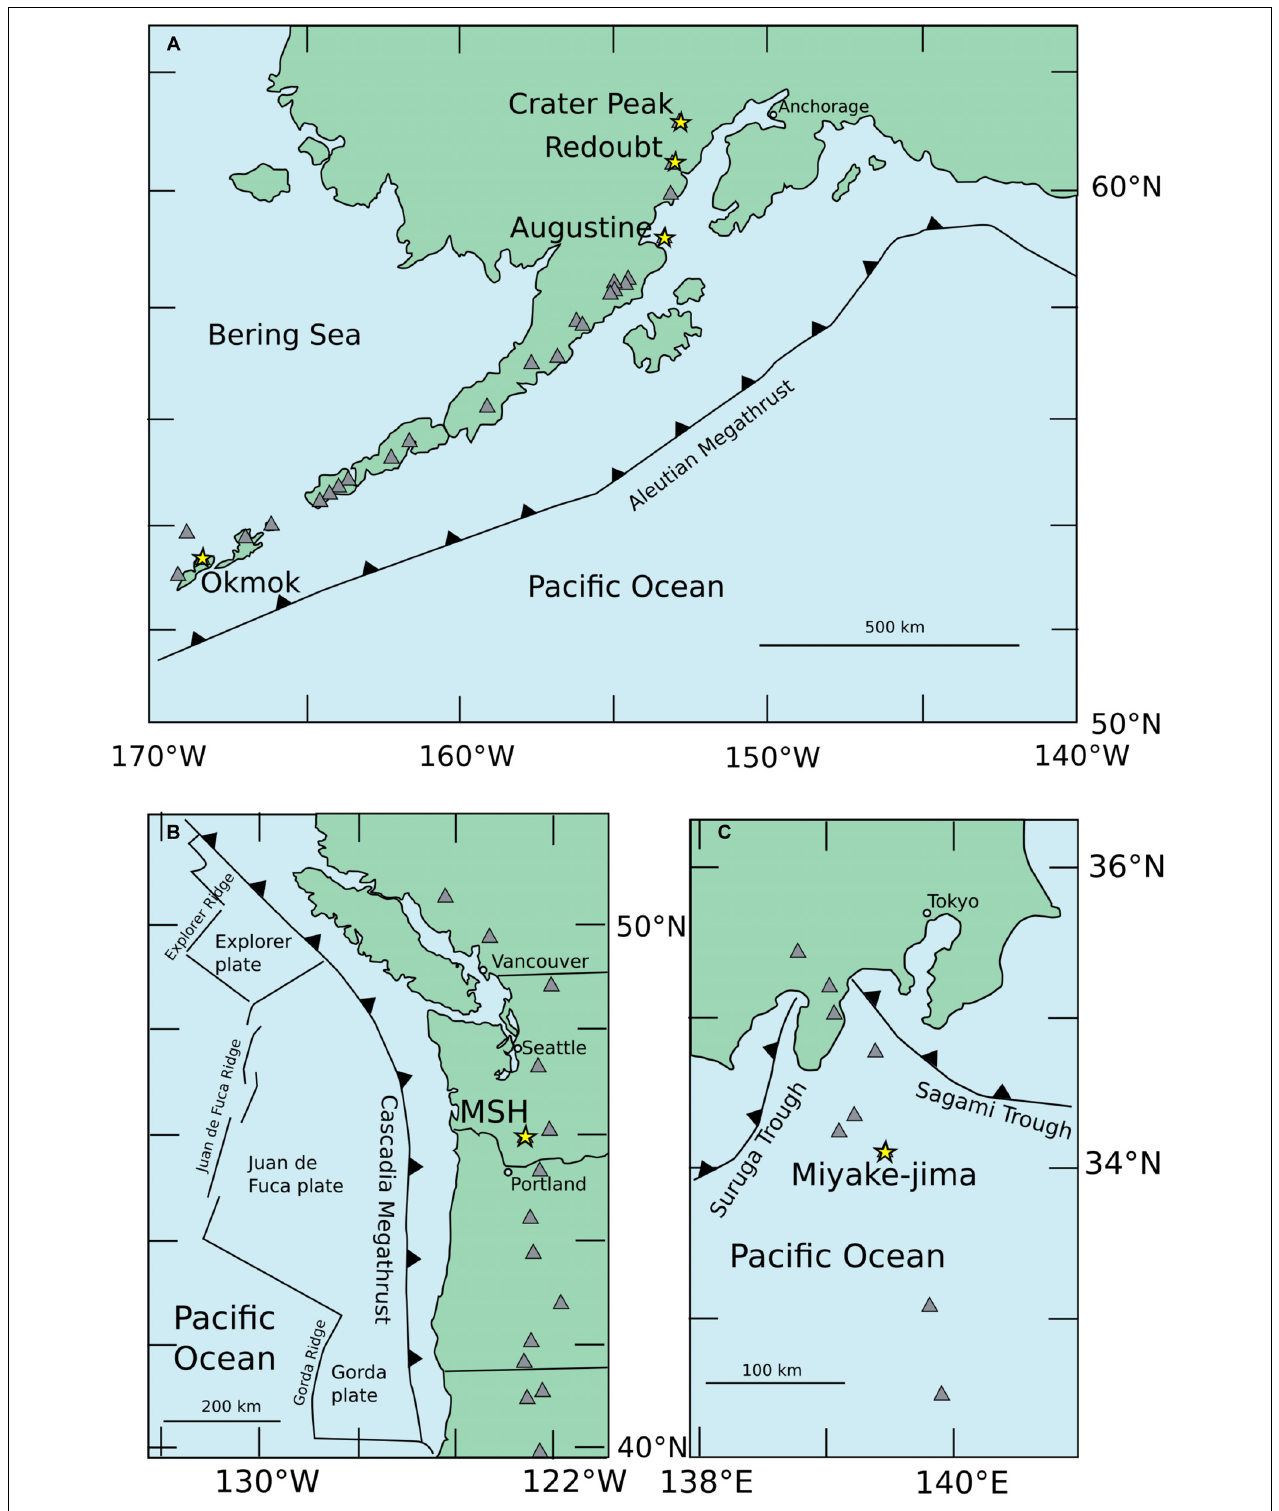
FIGURE 2 | Map showing the location (yellow stars) and general tectonic setting of the six volcanoes discussed in this study. Gray inverted triangles show nearby volcanoes not considered in this study. (A) Map of Alaska (United States) showing the locations of Crater Peak (Mt. Spurr), Redoubt, Augustine, and Okmok volcanoes. (B) Map of the Pacific Northwest region (United States) showing the location of Mt. St. Helens. (C) Map of Japan showing the location of Miyake-jima Volcano.